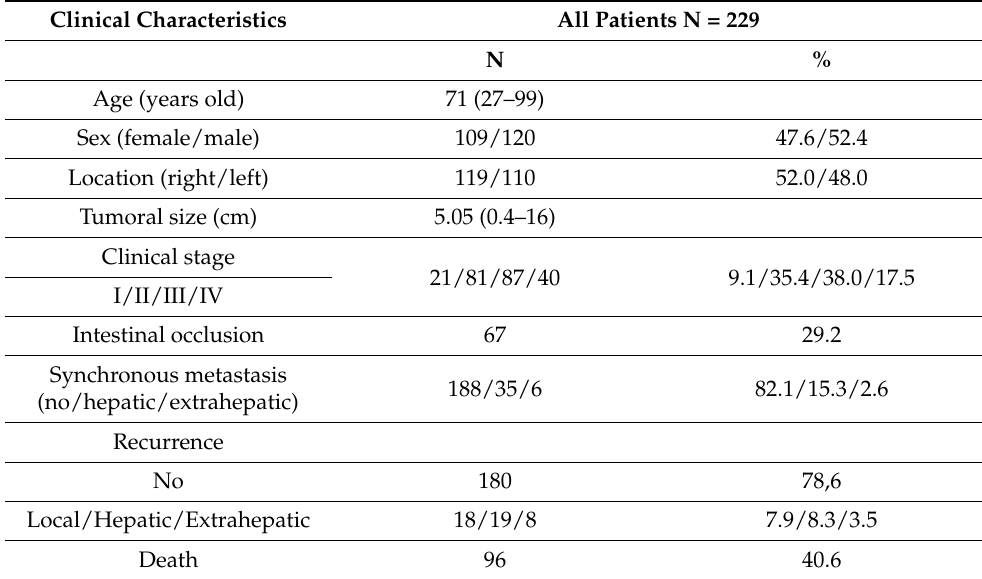
Table 1. Clinical characteristics of the cohort. Clinical